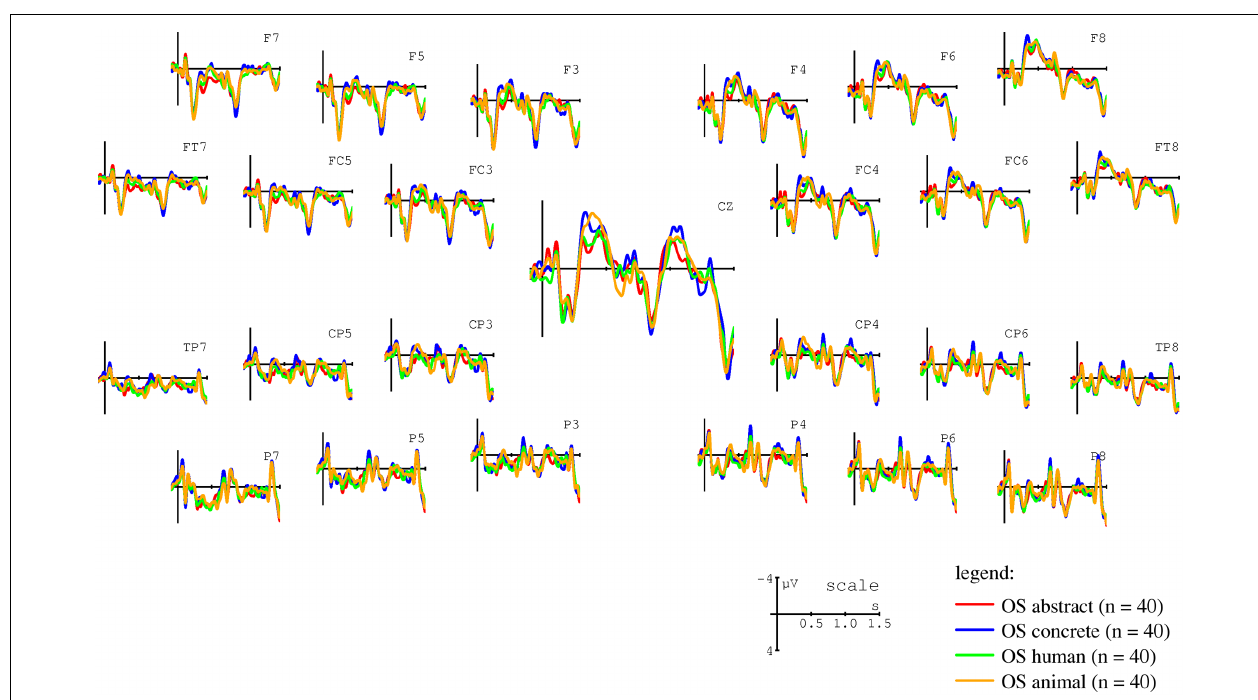
FIGURE 8 | Grand average ERPs time-locked to NP2 (onset at the vertical bar) in object-initial sentences. The figure contrasts human (hum; green line), non-human animate (yellow line), concrete inanimate (con; blue line), and abstract inanimate (abs; red line) actor arguments. Negativity is plotted upward.